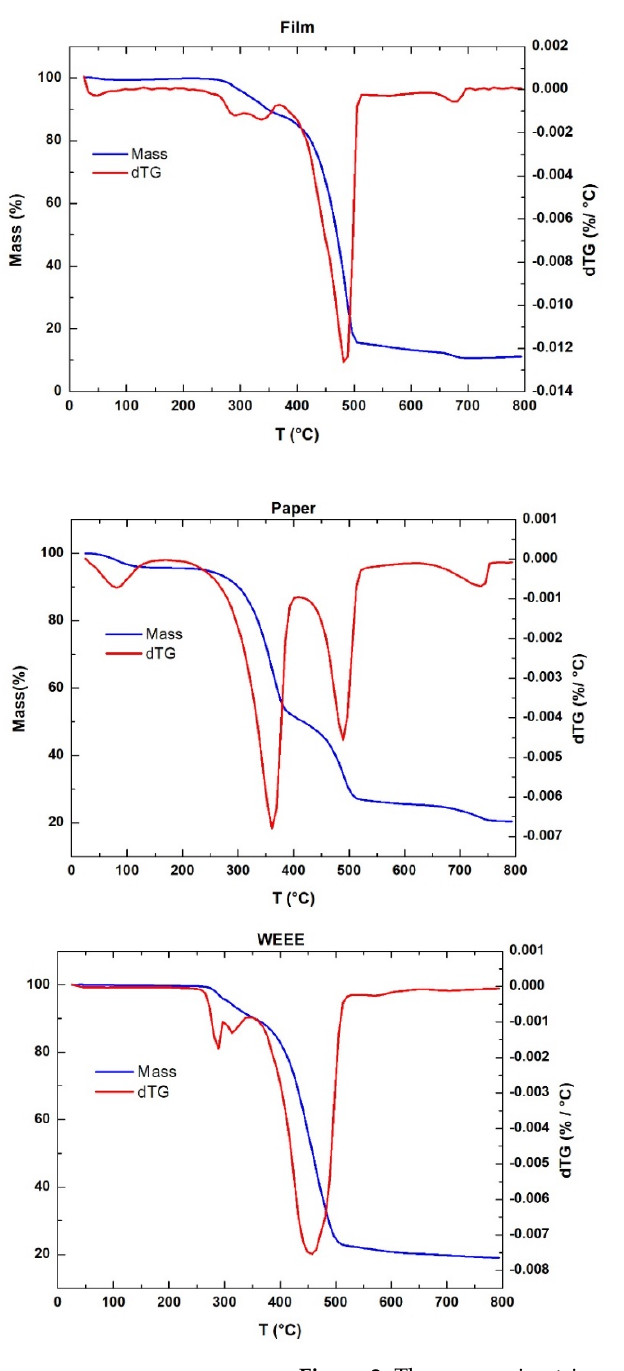
Figure 2. Thermogravimetric profiles of the raw and pre-treated waste samples.